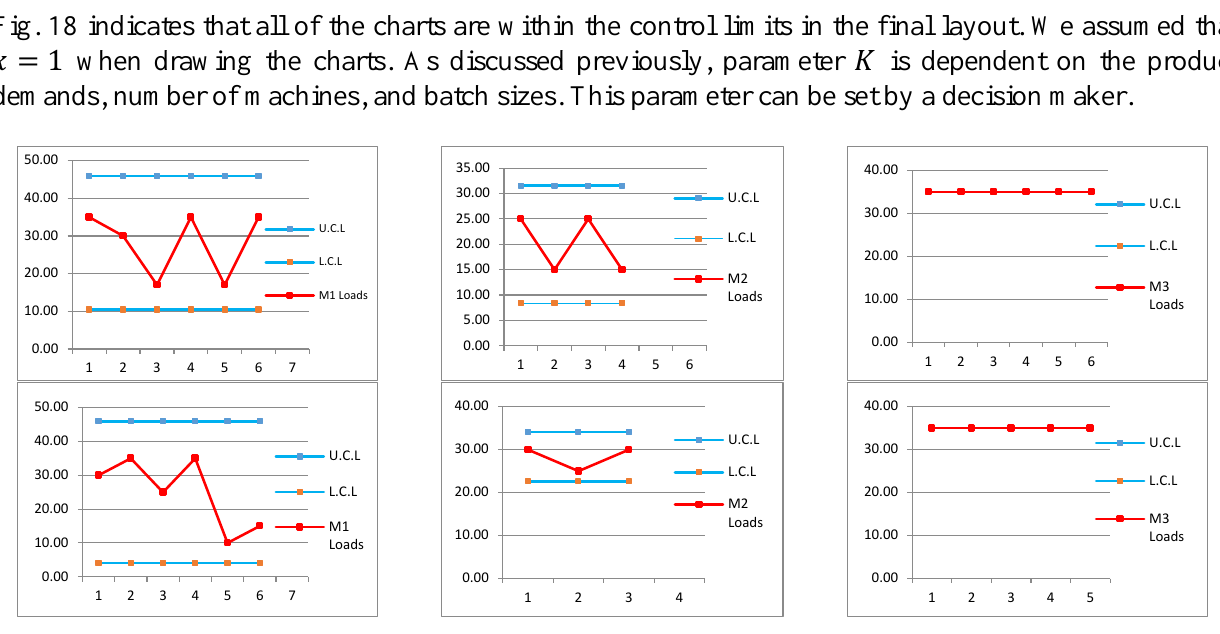
Fig. 18. Control charts for machine-loads in final result of the experiment 1